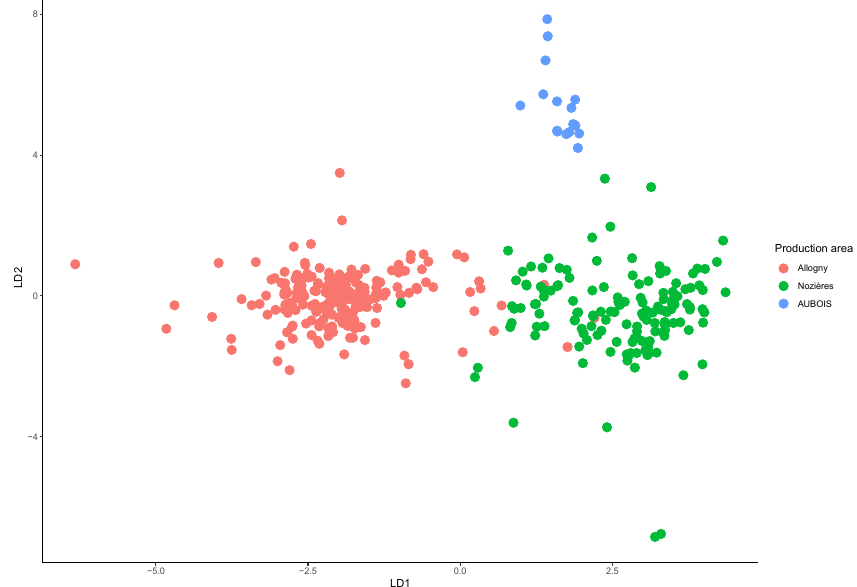
Figure 6. Linear discriminant analyses (LDA) on the Xij of the production areas.